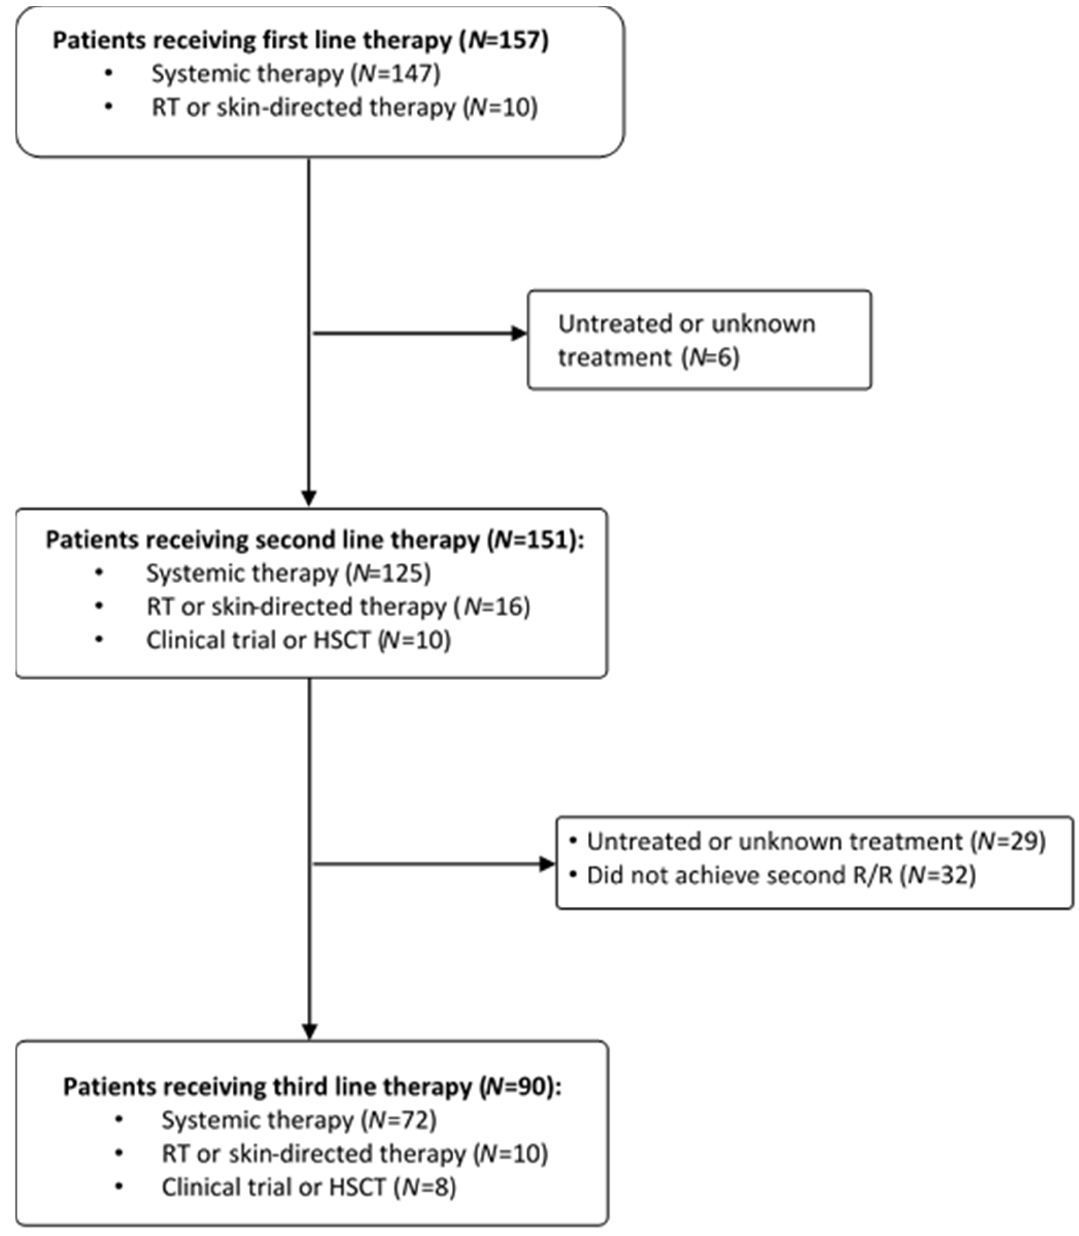
Figure 1. Patient flow diagram across lines of therapy. Abbreviations: HSCT: hematopoietic stem-cell transplantation; R/R: relapsed/refractory; RT: radiotherapy.